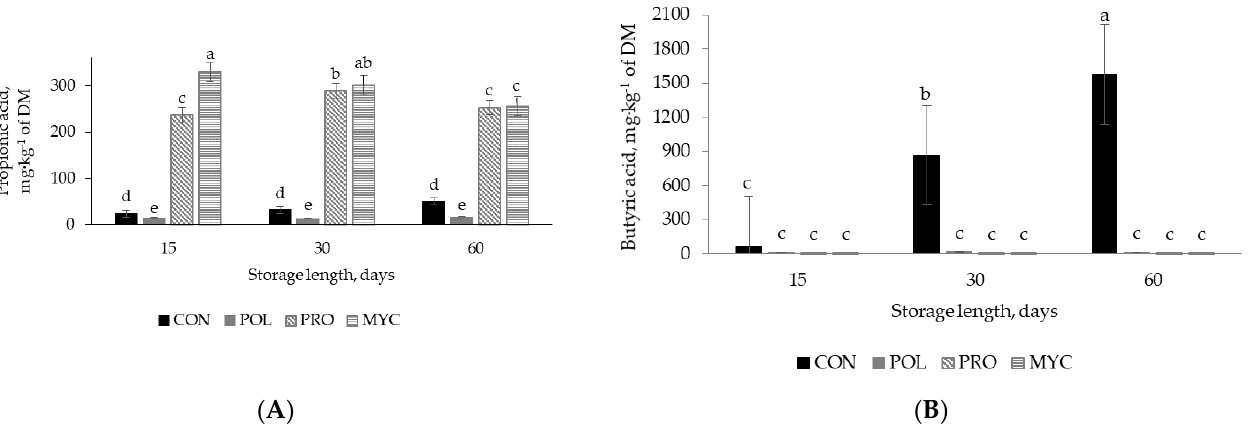
Figure 4. Propionic acid and butyric acid contents of reconstituted corn grain silage ensiled for 15, 30 or 60 d, without additives treatment (CON), or treated with polysorbate 80 (POL), propionic acid (PRO) or polysorbate 80 and propionic acid (MYC). Statistical effects observed for ( A ) Propionic acid – Additive, p < 0.01; Storage, p < 0.01; A × S, p < 0.01, SEM = 6.11; ( B ) Butyric acid – Additive, p < 0.01; Storage, p < 0.01; A × S, p < 0.01, SEM = 133.4. Different letters differ by Tukey’s test ( p ≤ 0.05). The aerobic stability of the RCGS increased ( p < 0.05) from d-15 to d-30 d, but did not change from d-30 to d-60 (Figure 5A). At d-15 of storage, the PRO and MYC treatments decreased the DM losses. At d-30, the propionic acid was more efficient at controlling the losses in the silo, and at d-60 all treated silages presented a lower ( p < 0.05) DM loss than CON (Figure 5B).